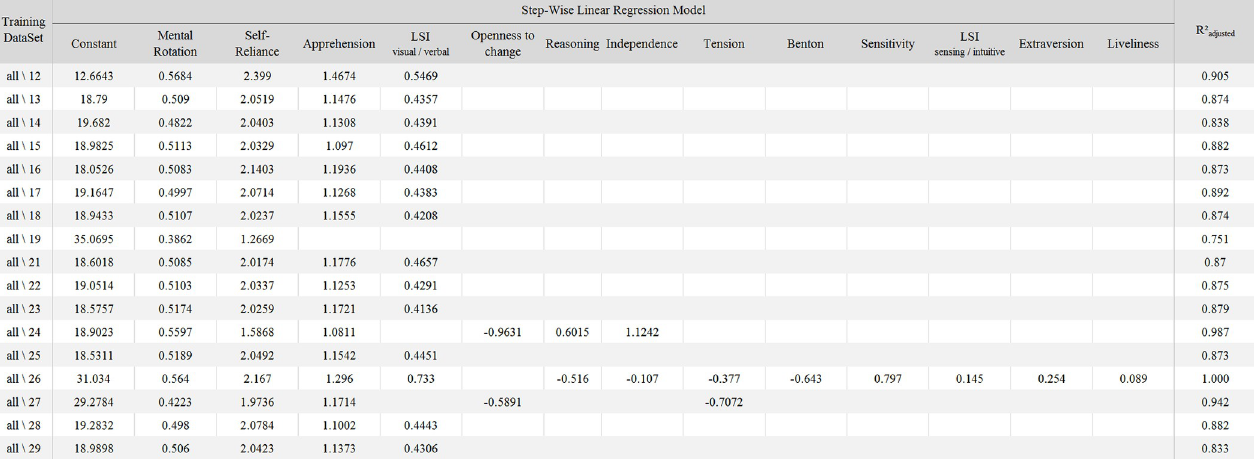
Fig 6. The 17 models generated from leave-one-subject-out cross validation process. The coefficients for each factor that was included in the model generated from the training datasets ( all\XX meaning that the training dataset was composed of all the participants except XX) are detailed in each row.